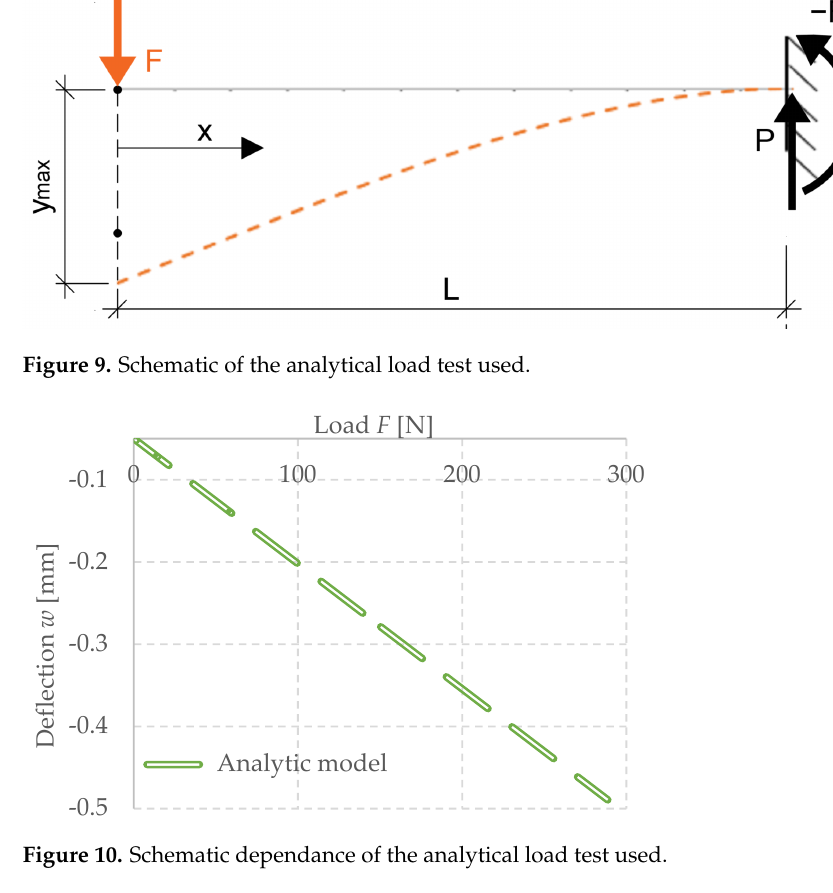
Figure 10. Schematic dependance of the analytical load test used. Table 2. Selected material characteristics of foam concrete